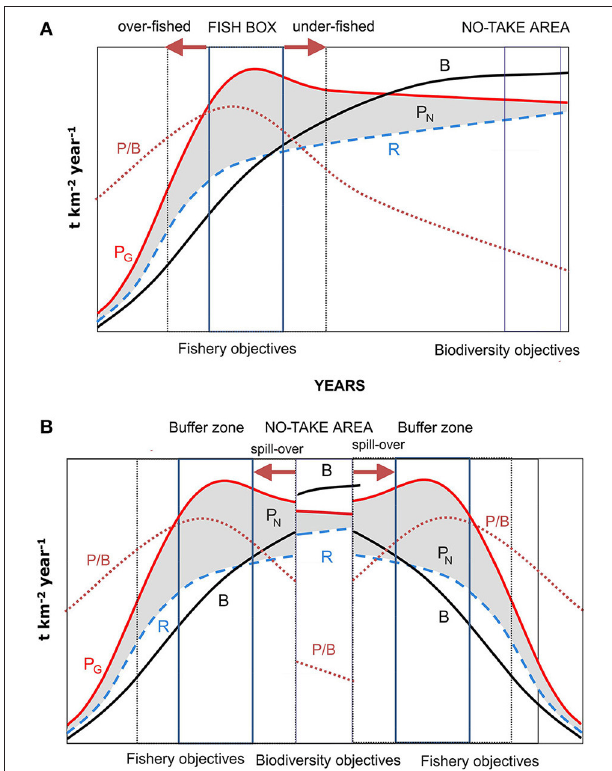
FIGURE 2 | (A) Energetic of succession in an ecosystem. P G , gross production; P N , net production; R, total community respiration; B, total biomass; P/B, productivity (Modified from Odum’s, 1969). The fishing activity (and the objectives of fish boxes) focuses on the early stages of ecological succession, where net production is maximum. But any deviation from the optimum of fishing pressure moves the ecosystem to stages with lower net production. By contrast, conservation objectives focus on late stages, where maximum biomass is reached and the ecosystem reaches maturity and complexity, but net exploitable production is minimal. (B) Southern European MPAs have a central no-take area whereby ecological succession leads the ecosystem to maturity, flanked by buffer zones managed like the fish box. The export of biomass from the no take area to the buffer zone dampens the catch fluctuations derived from deviations from optimal effort in the fishing